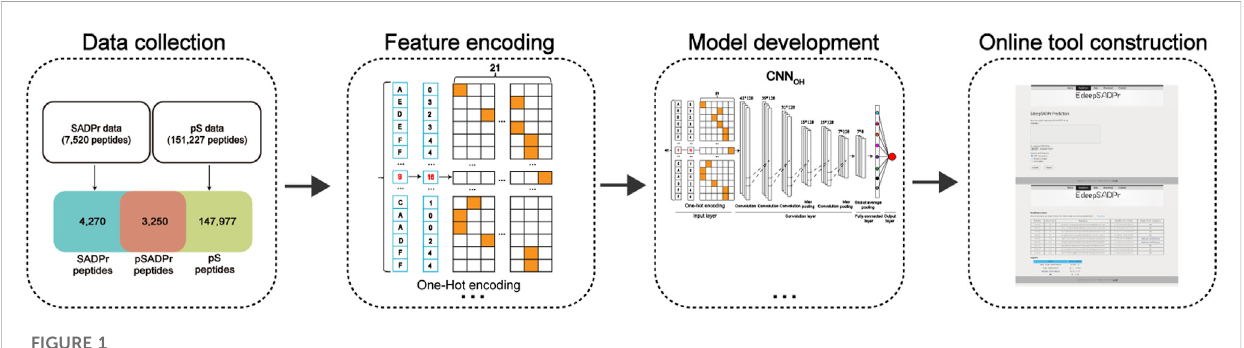
FIGURE 1 Flowchart of the model